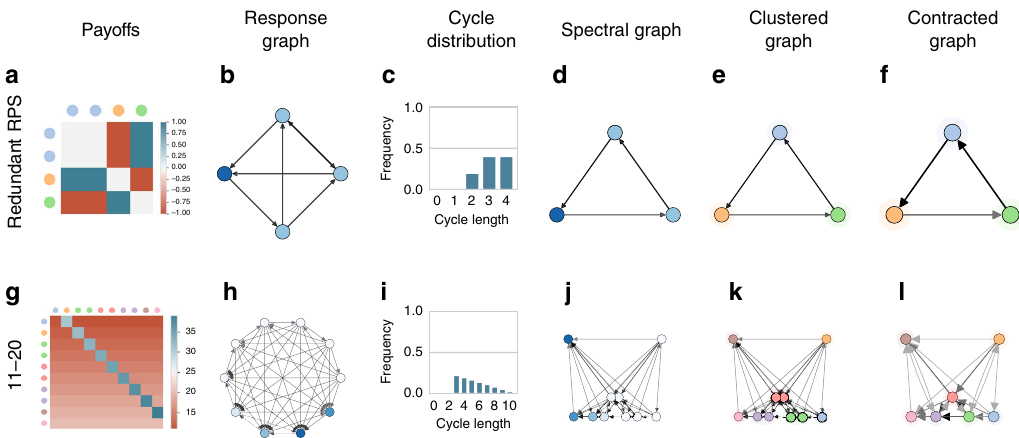
Fig. 5 Results for redundant Rock – Paper – Scissors (RPS) and 11 – 20 game. In Redundant RPS, the redundant copy of the fi rst strategy (Rock) is clustered in the spectral response graph. In 11 – 20, seven clusters of strategies are revealed, exposing the cyclical nature of this game.